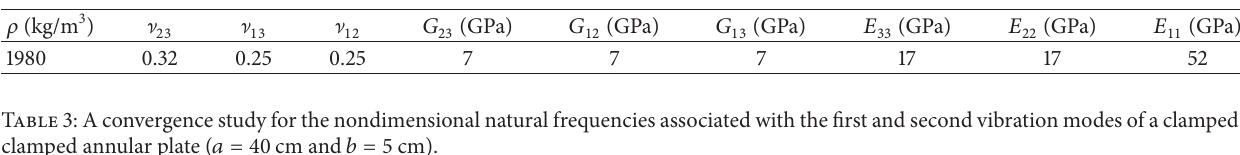
Table 2: Mechanical properties of S2-glass.